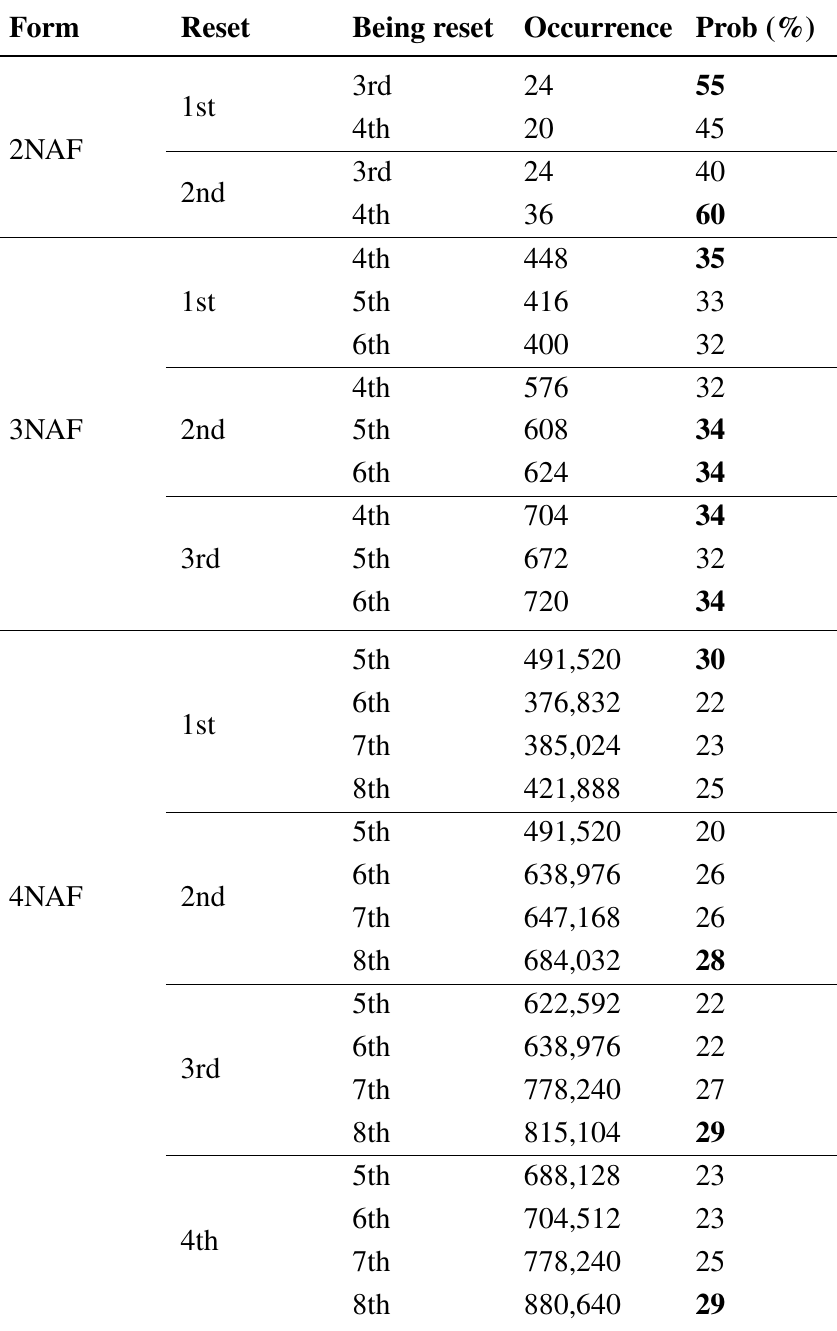
Table 2. Relation of neighbor bit reset in w -NAF representation; we tested all cases for evaluation, so occurrence means number of